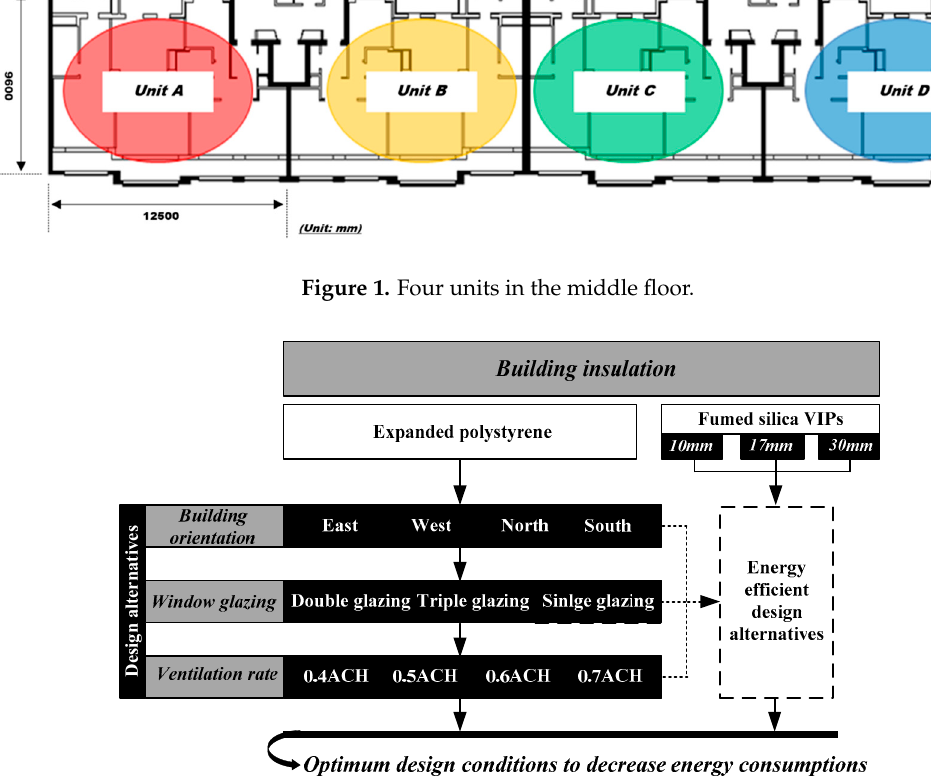
Figure 2. Setup of design alternatives. Table 2. Boundary conditions for energy simulation.